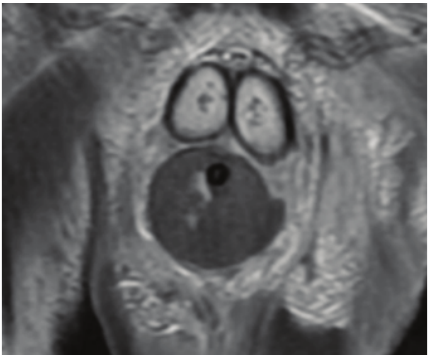
Figure 2: A representative MRI T1 image after gadolinium showing a coronal cut of the base of the penis with both corpora cavernosa having high signal intensity due to gadolinium uptake whereas the corpus spongiosum does not uptake